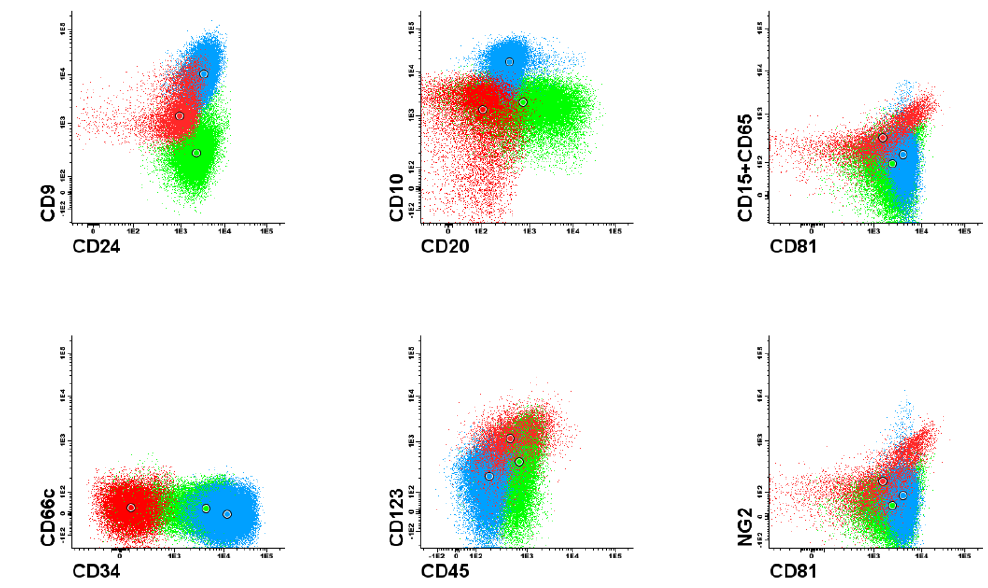
Figure 2. Example of 2–dimensional visualisation illustrating poor separation of patients with different genetic aberrations based on phenotypic